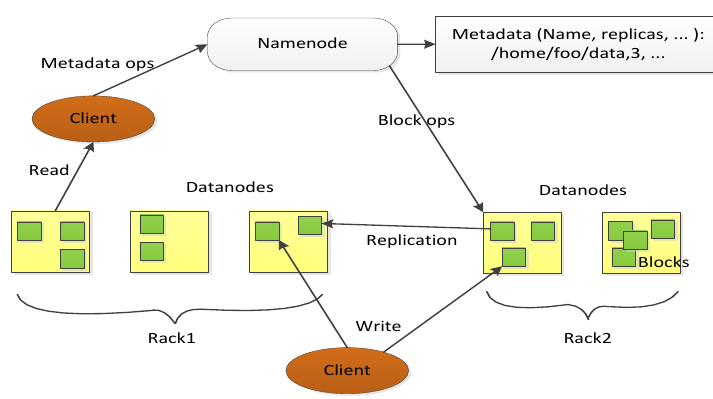
Figure 3. The HDFS architecture